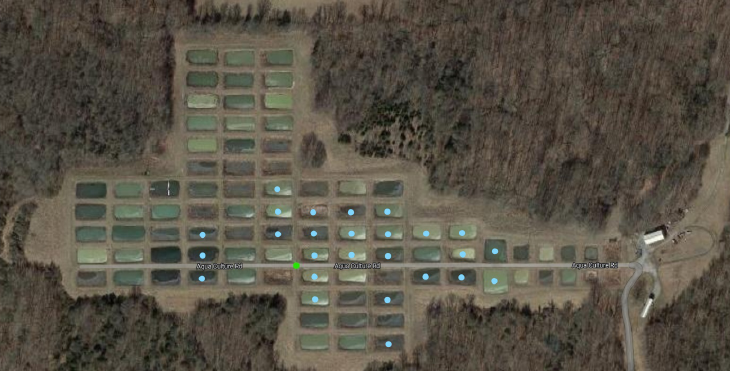
Figure 8. Southern Illinois University Aquaculture Research Center. The takeoff location is marked with a green dot, all available ponds are marked with a blue dot.